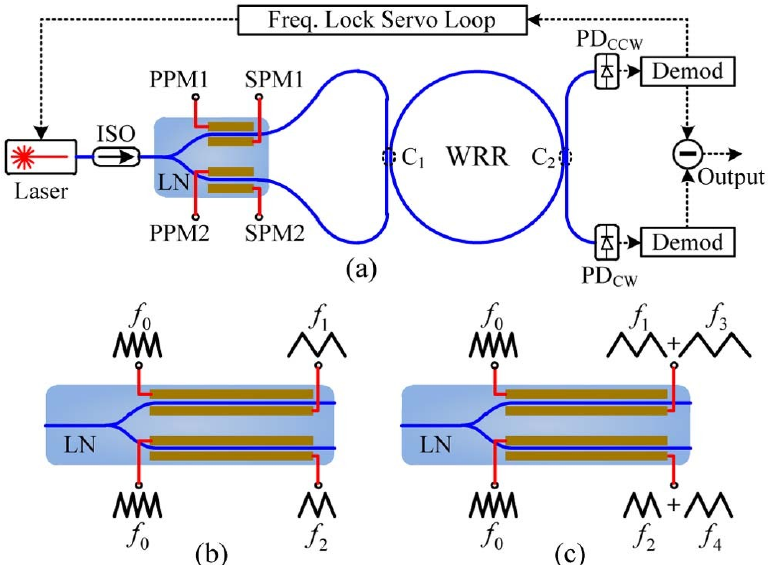
Figure 10. ( a ) Schematic diagram of a RIOG using PDT. ( b , c ) Two types of PDT implementations. LN: lithium niobate modulator; SPM: secondary phase modulation; PPM: primary phase modulation; Demod: demodulation. Reprinted with permission from ref. [28]. Copyright 2016 The Optical